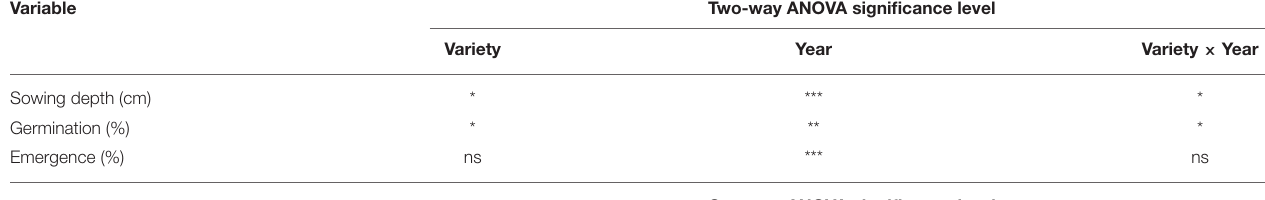
TABLE 5 | Results of two-way ANOVA showing the effects of variety, year, and variety × year interaction on the mean sowing depth and the final mean germination and emergence rates, and the results of one-way ANOVA on the mean germination and emergence rates at each counting for individual experimental year.